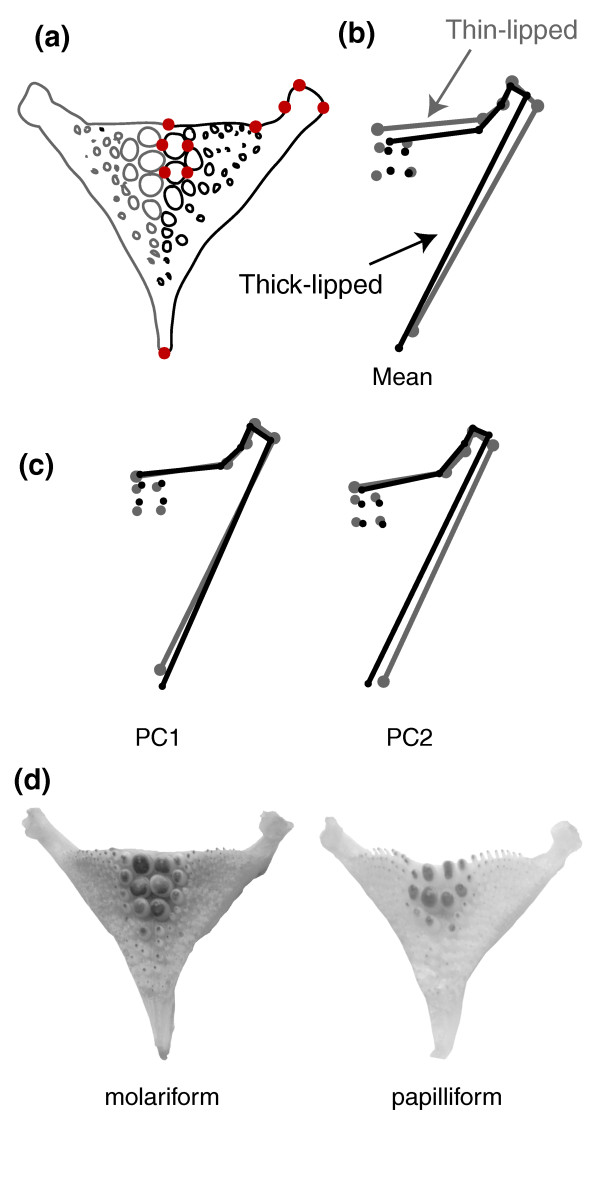
Thick-lipped and thin-lipped Midas cichlids in Apoyeque differ in the shape of their pharyngeal jaws. (a) Ten homologous landmarks describe jaw shape using one side. (b) Discriminant function analysis of mean shape of thick-lipped (black; n = 36) and thin-lipped (grey; n = 135) pharyngeal jaws (scale factor = 4). (c) The morphological variation associated with the first two principal component axes (scale factor = 4), responsible for most of the shape variation. (d) Exemplars of a molariform and papilliform pharyngeal jaws from Apoyeque Midas cichlids. Note the squatter, broader teeth and thicker horns in the more molariform jaw.